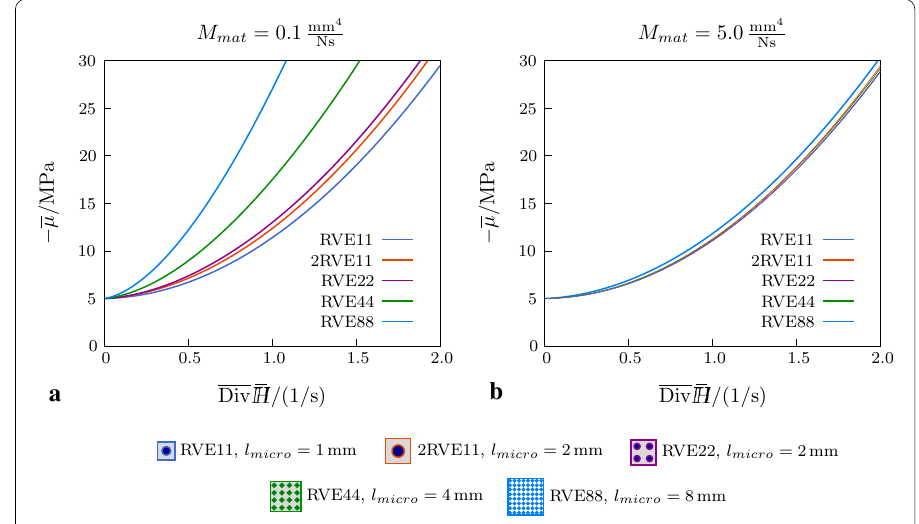
Fig. 7 Effective chemical potential depending on the size of the RVE and the mobility parameter of the matrix. The evolution of the macroscopic chemical potential μ for different realizations of RVEs is depicted as a function of the divergence of the macroscopic solvent-volume flux Div H for selected mobility parameters of the matrix given by a M mat = 0 . 1 mm 4 / (Ns) and b M mat = 5 . 0 mm 4 / (Ns). Like in the previous study (Fig. 6) we observe that the effective chemical potential μ depends strongly on the size of the RVE. The observed discrepancies decrease with increasing mobility parameter of the matrix